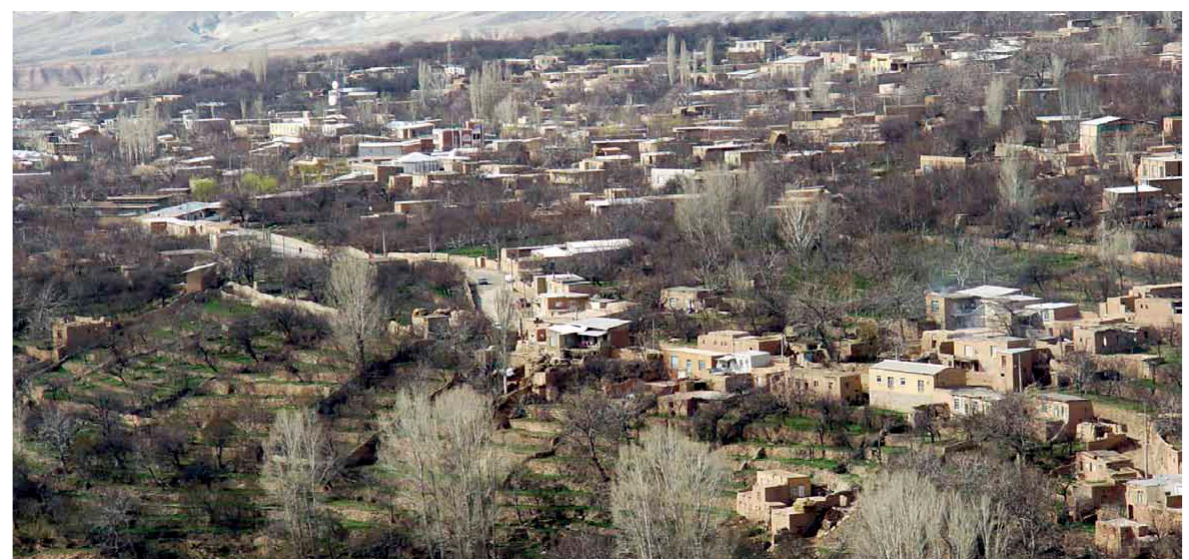
fig. 3. a panorama view of garden city (photo by the